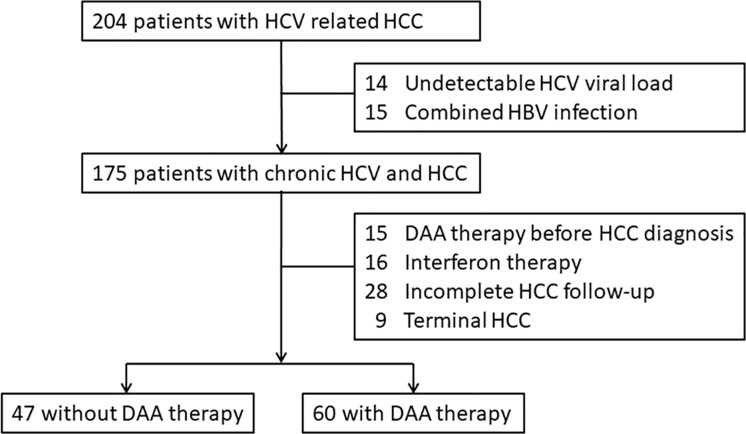
Flowchart of the patients in the study.